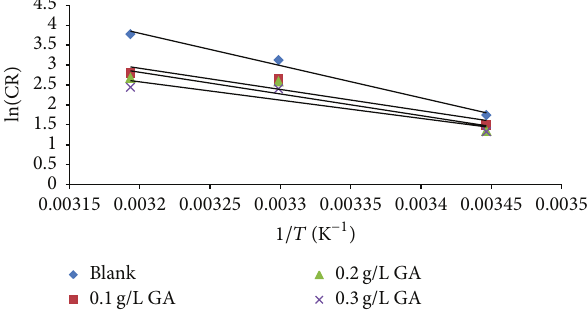
Figure 6: Logarithm of corrosion rate (CR) against inverse temper- ature for mild steel with and without GA in